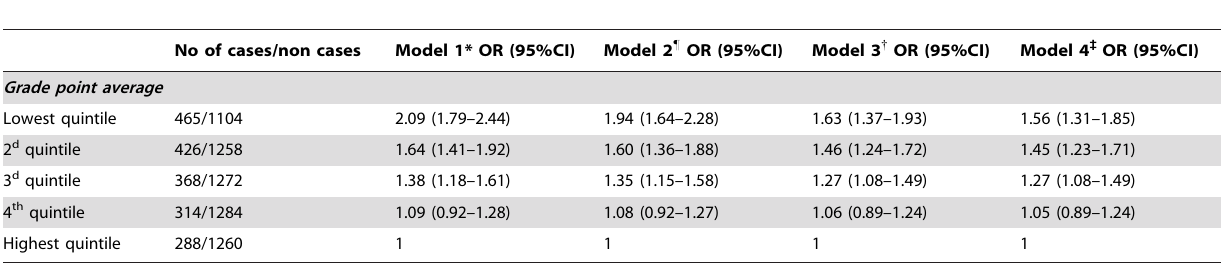
Table 1. Odds ratios (OR) and 95% confidence intervals (CI) of lifetime suicidal thoughts in relation to compulsory school leaving grades among young adults aged 18–29 in the Stockholm Public Health